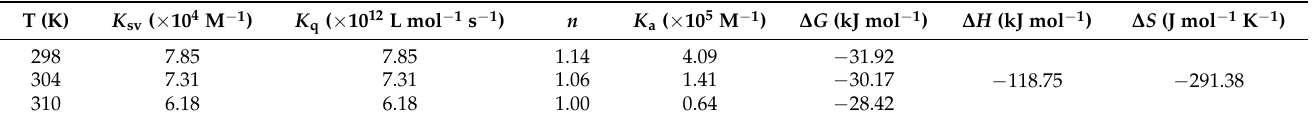
Table 3. Association constants and thermodynamic parameters at different temperatures for the HSA–GDC-0941 interaction.